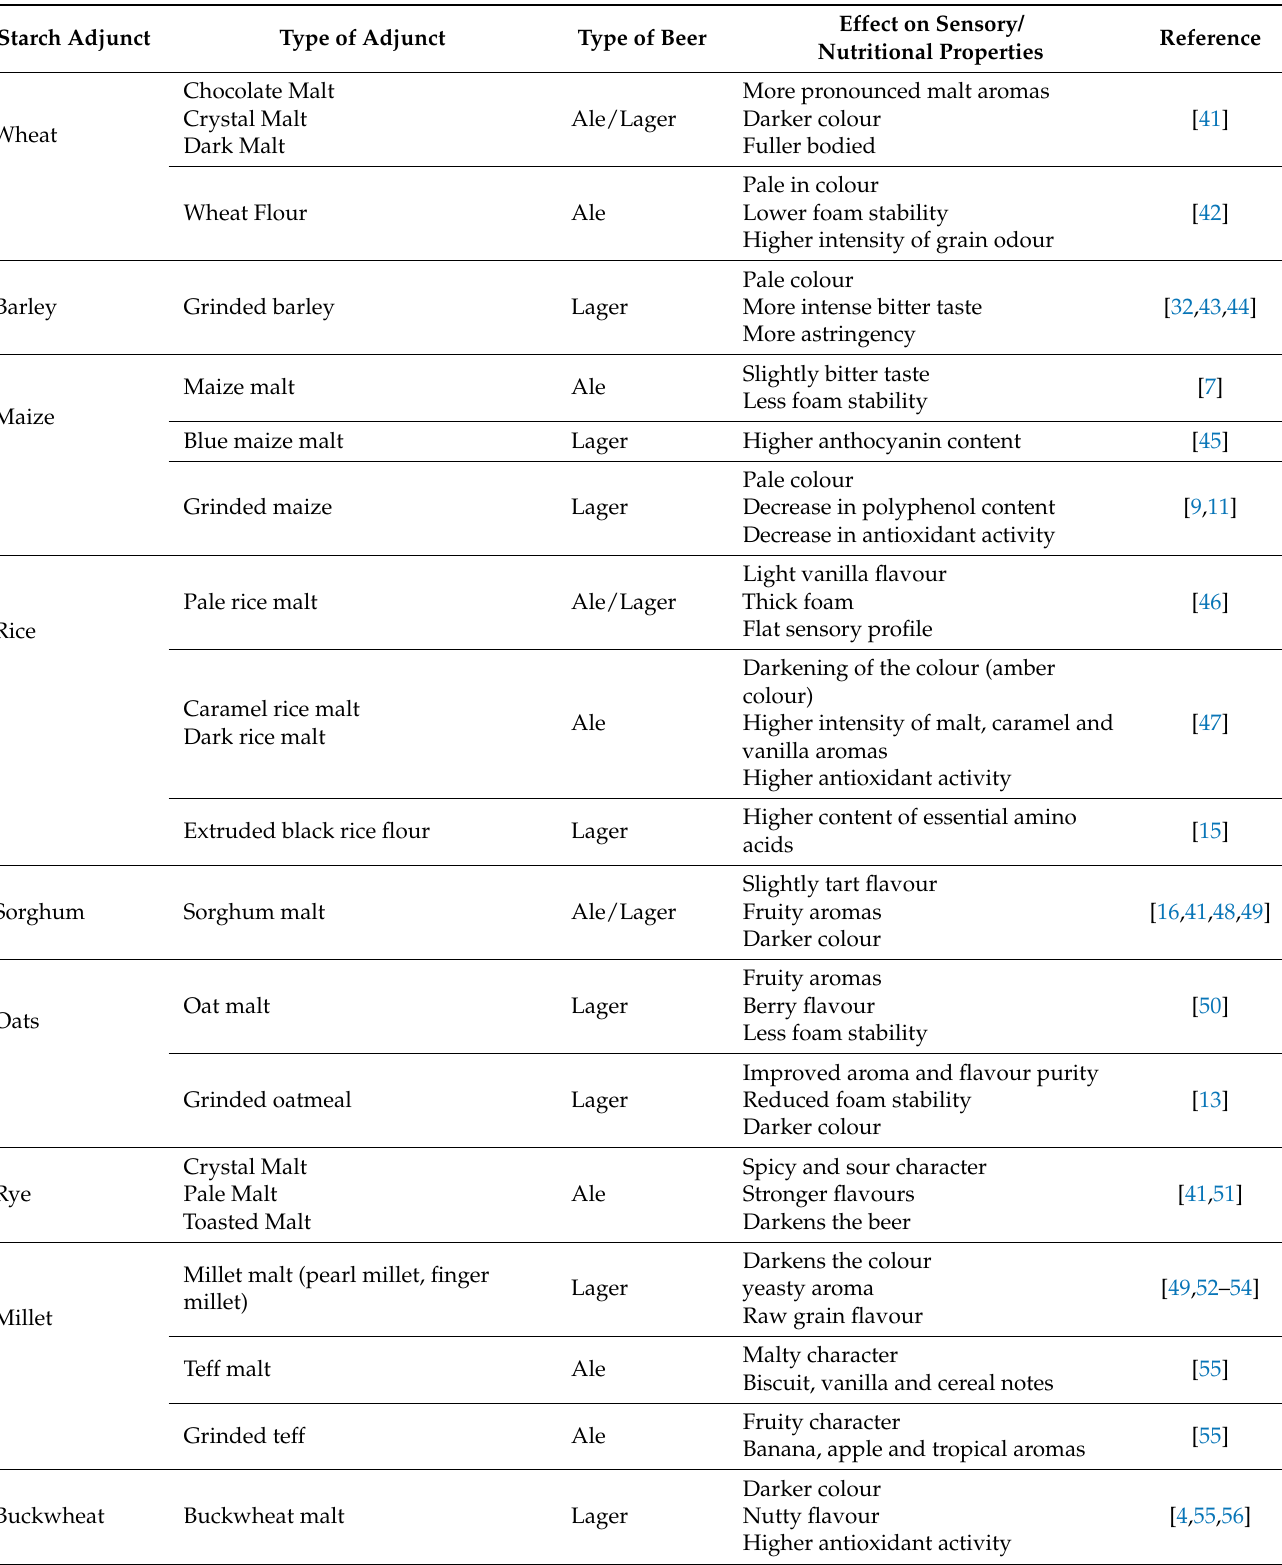
Table 4. Starch adjuncts used in brewing, correlation with beer type and effects on sensory/nutritional properties. Starch